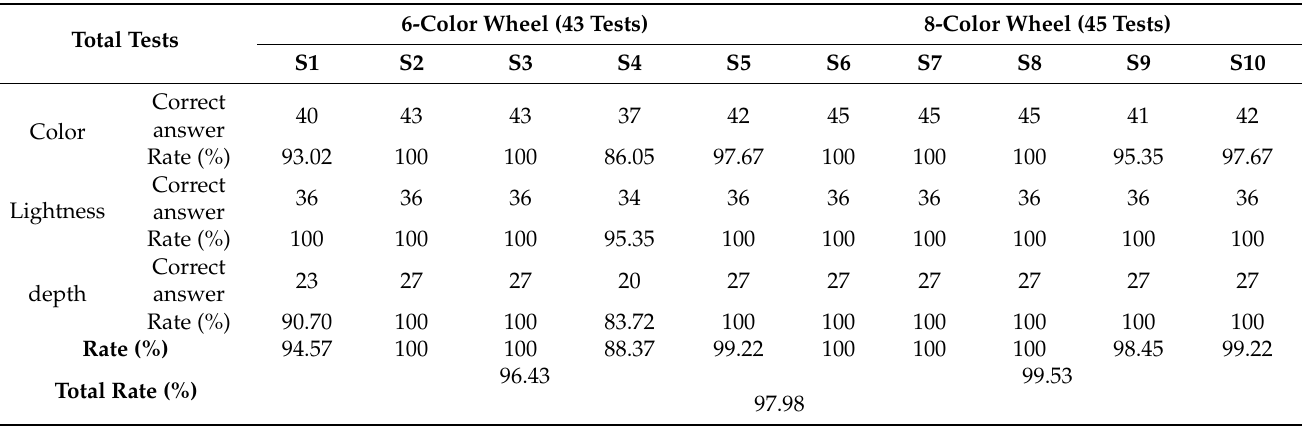
Table 11. Identification test results for each